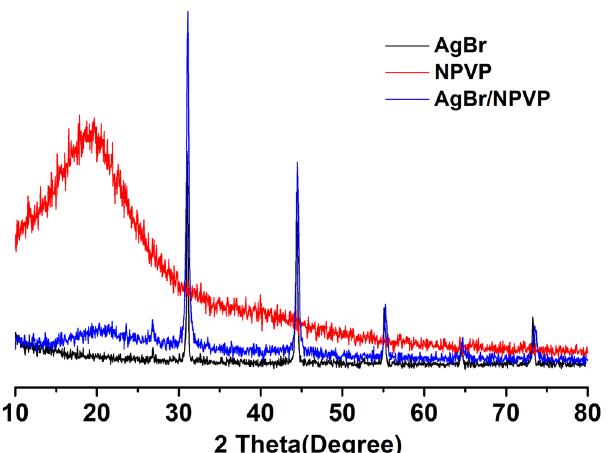
Figure 3. XRD patterns of AgBr, NPVP and AgBr/NPVP. The diffraction peaks located at 19.68° and 31.06°, 44.38°, 55.08°, 64.53°, 73.32° could be well indexed on the NPVP and AgBr crystal planes of (2 0 0), (2 2 0), (2 2 2), (4 0 0) and (4 2 0),